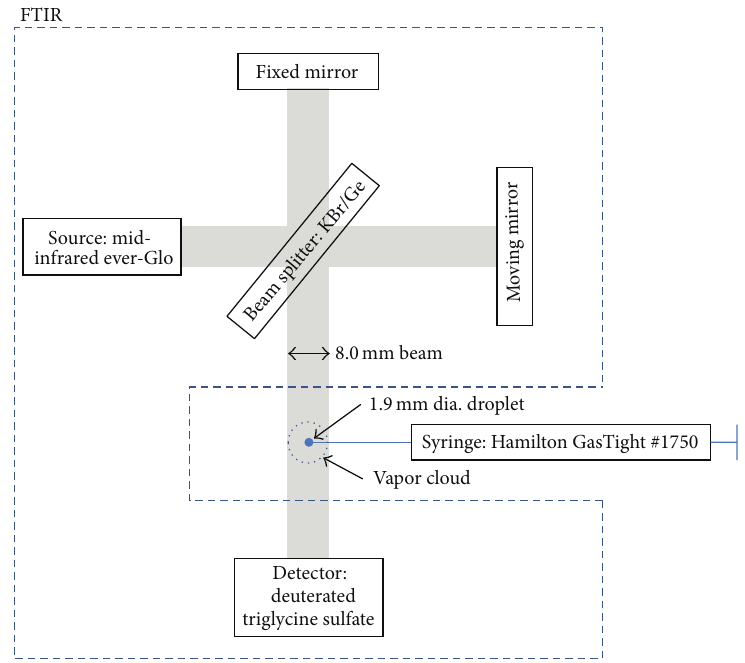
Figure 3: Experimental layout of droplet in FTIR beam path.